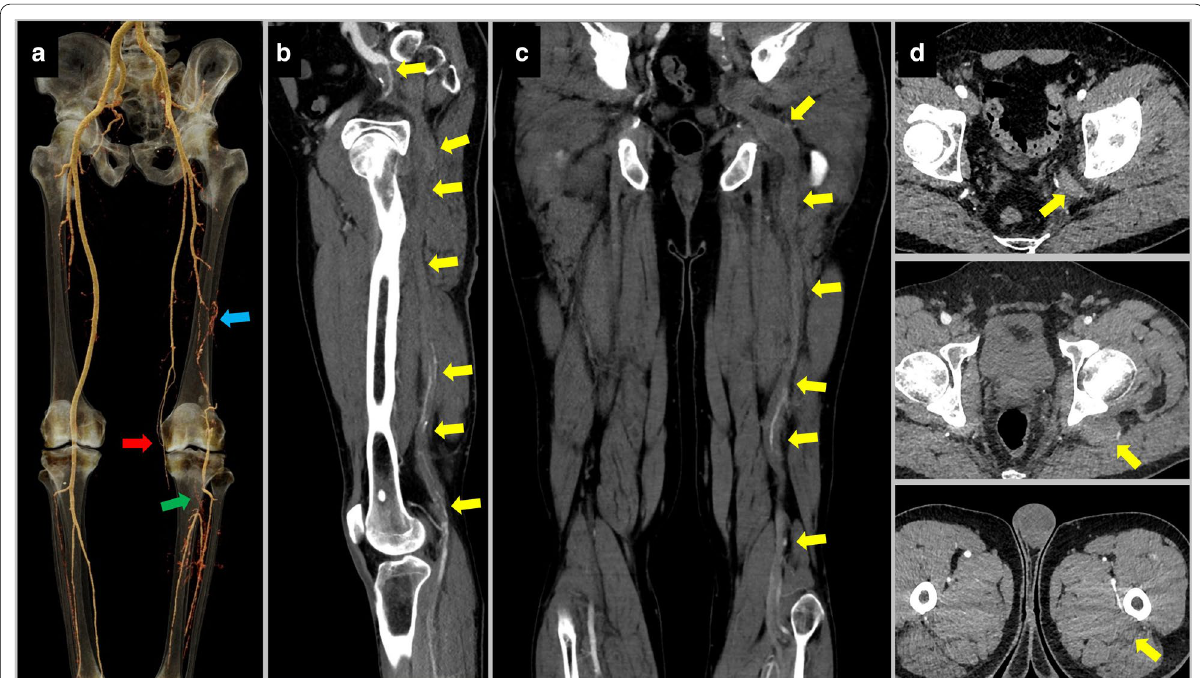
Fig. 5 Lack of knowledge (type 3) error. A 55-year-old male patient underwent lower extremity CTA due to signs of peripheral artery disease in the left lower extremity. The radiology resident who examined the CTA for the preliminary results saw that the left superficial femoral artery was of thin caliber and ended at the knee level. He thought that it was chronically occluded (red arrow, a ). He also thought that collaterals between the left deep femoral artery and popliteal artery (blue arrow, a ) had developed secondary to the thrombi in the left popliteal artery (green arrow, a ). When the radiologist referred the CTA to the attending physician, he learned that the patient’s left internal iliac artery continued as the popliteal artery, which is a variation called persistent sciatic artery. The persistent sciatic artery of the patient was thrombosed throughout its course (yellow arrows, b , c , d ). The resident could not recognize this variation and the pathology due to the lack of knowledge. Although this is not a common variation that should be known by every radiologist, in this case, failure to recognize the thrombosed persistent sciatic artery could have adversely